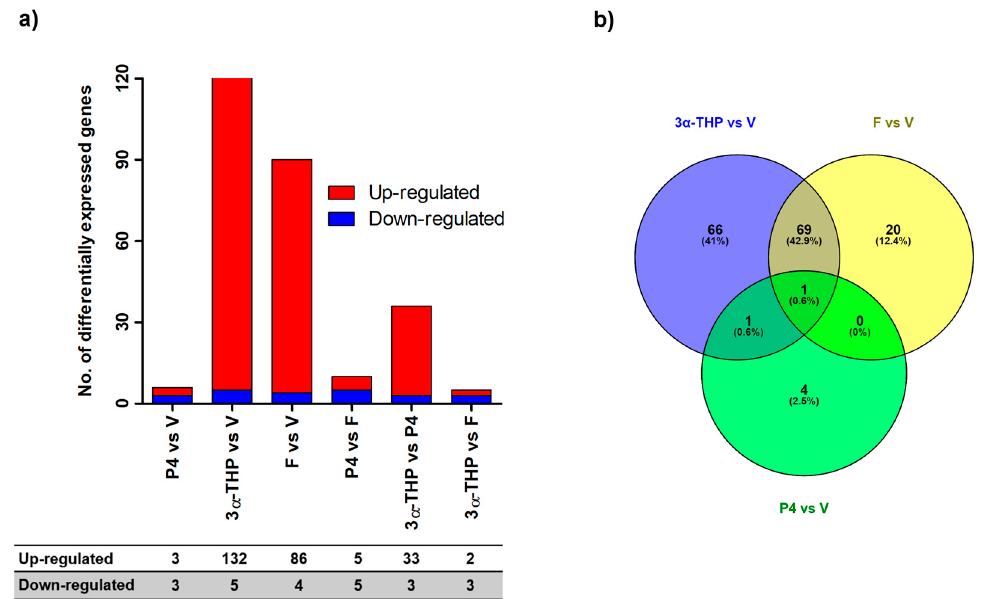
Figure 1. Progesterone (P4), allopregnanolone (3 α -THP), and finasteride (F) promote changes in the gene expression profile of U87 cell line. ( a ) The number of differentially expressed genes with a Fc > ± 1.5 and p < 0.05 between different treatment comparisons. The table shows the number of up- and down-regulated genes. ( b ) The genes that changed their expression under the treatment of P4, 3 α -THP, and F vs. vehicle (V), respectively were used to build a Venn’s diagram with the program Venny. 3 α -THP and F differentially regulated 69 genes while 3 α -THP and P4 regulated one, and the three steroids regulated the expression of one transcript.